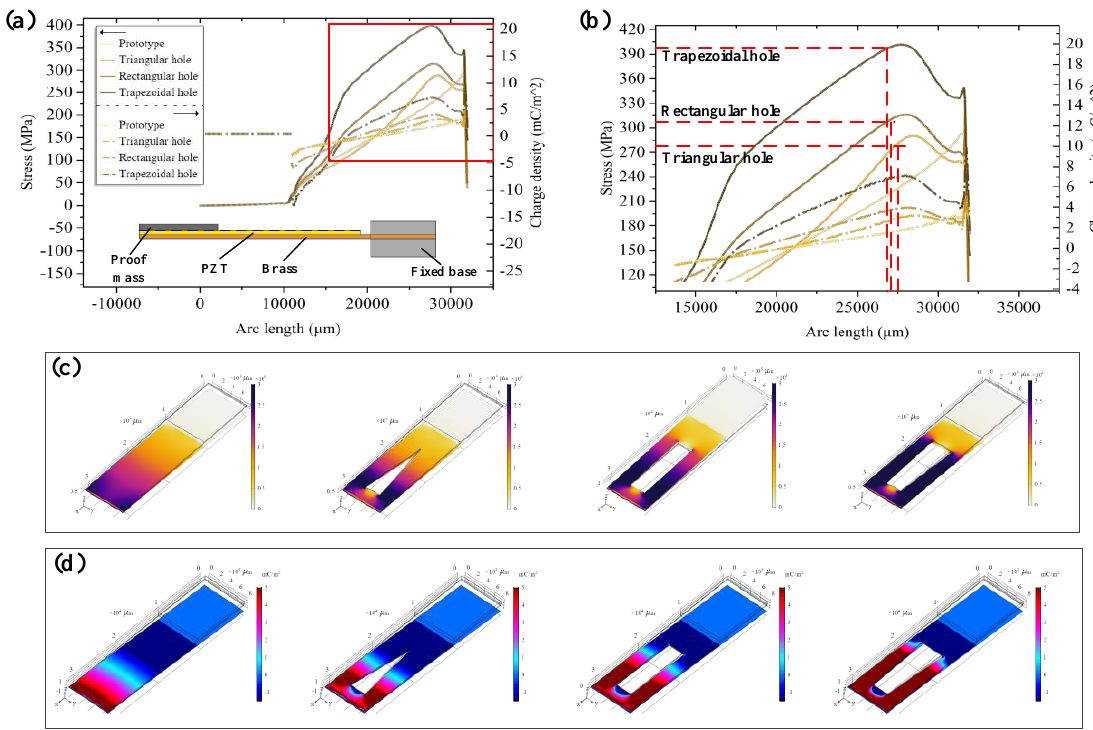
Micromachines 2021 , 12 , x FOR PEER REVIEW Figure 7. Simulation results of four types of piezoelectric energy harvesters. ( a ) The stress level and charge density on the outside of the piezoelectric layer. ( b ) Comparison of stress level and charge density of devices. ( c ) The surface stress levels of B-PEHs with different hollow structures. ( d ) The surface charge density of B-PEHs with different hollow structures.